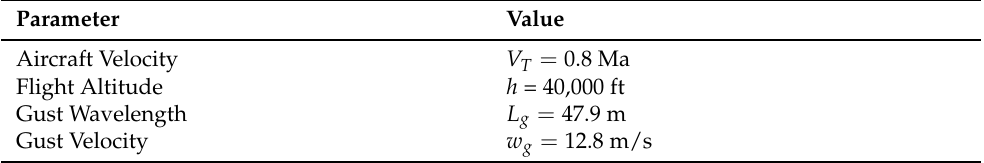
Table 2. Flight condition